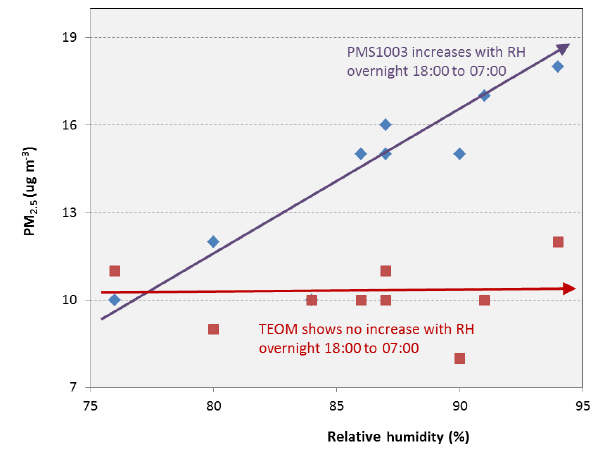
Figure 4. The hourly PM 2 . 5 concentration reported by the PMS1003 and TEOM over a humid night (7 August) at the outdoor monitoring station. The arrows show the changing trends.